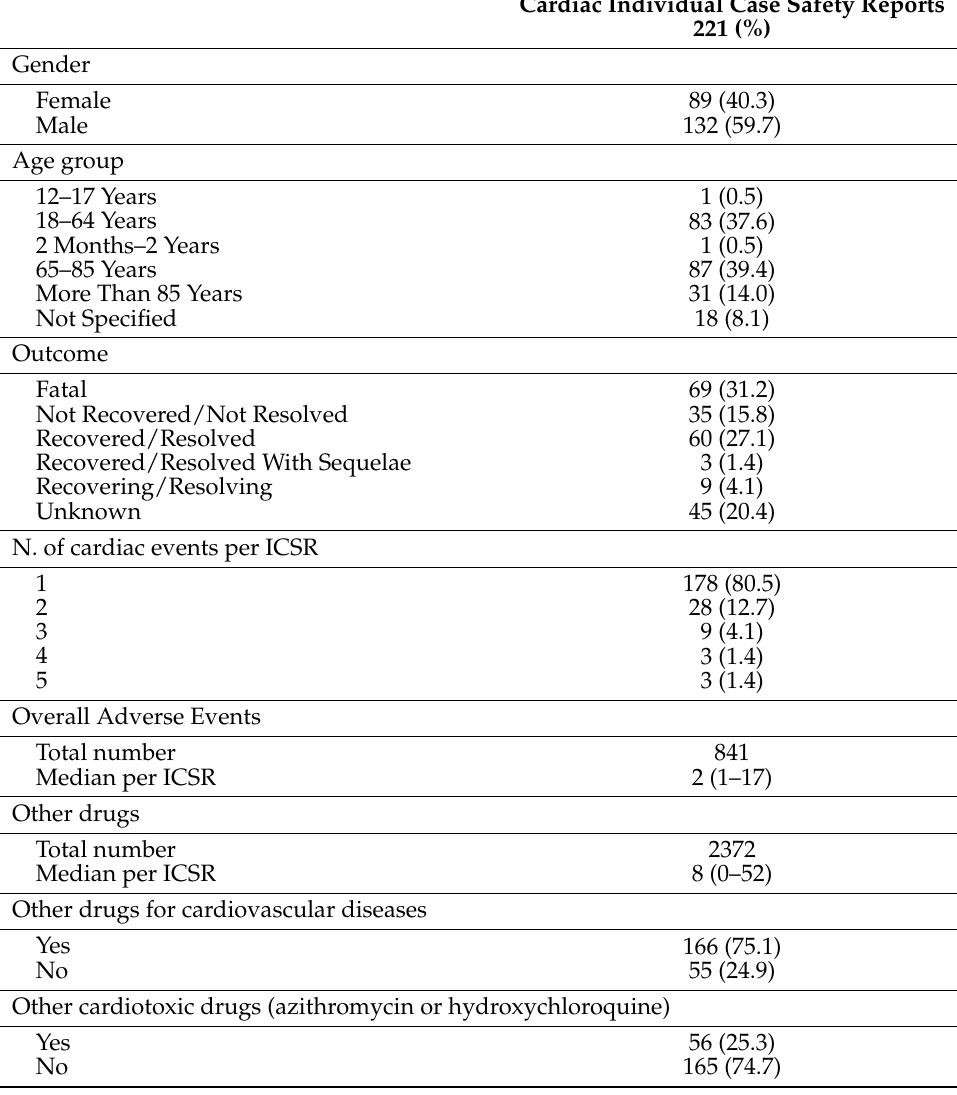
Table 4. Characteristics of 221 cardiac Individual Case Safety